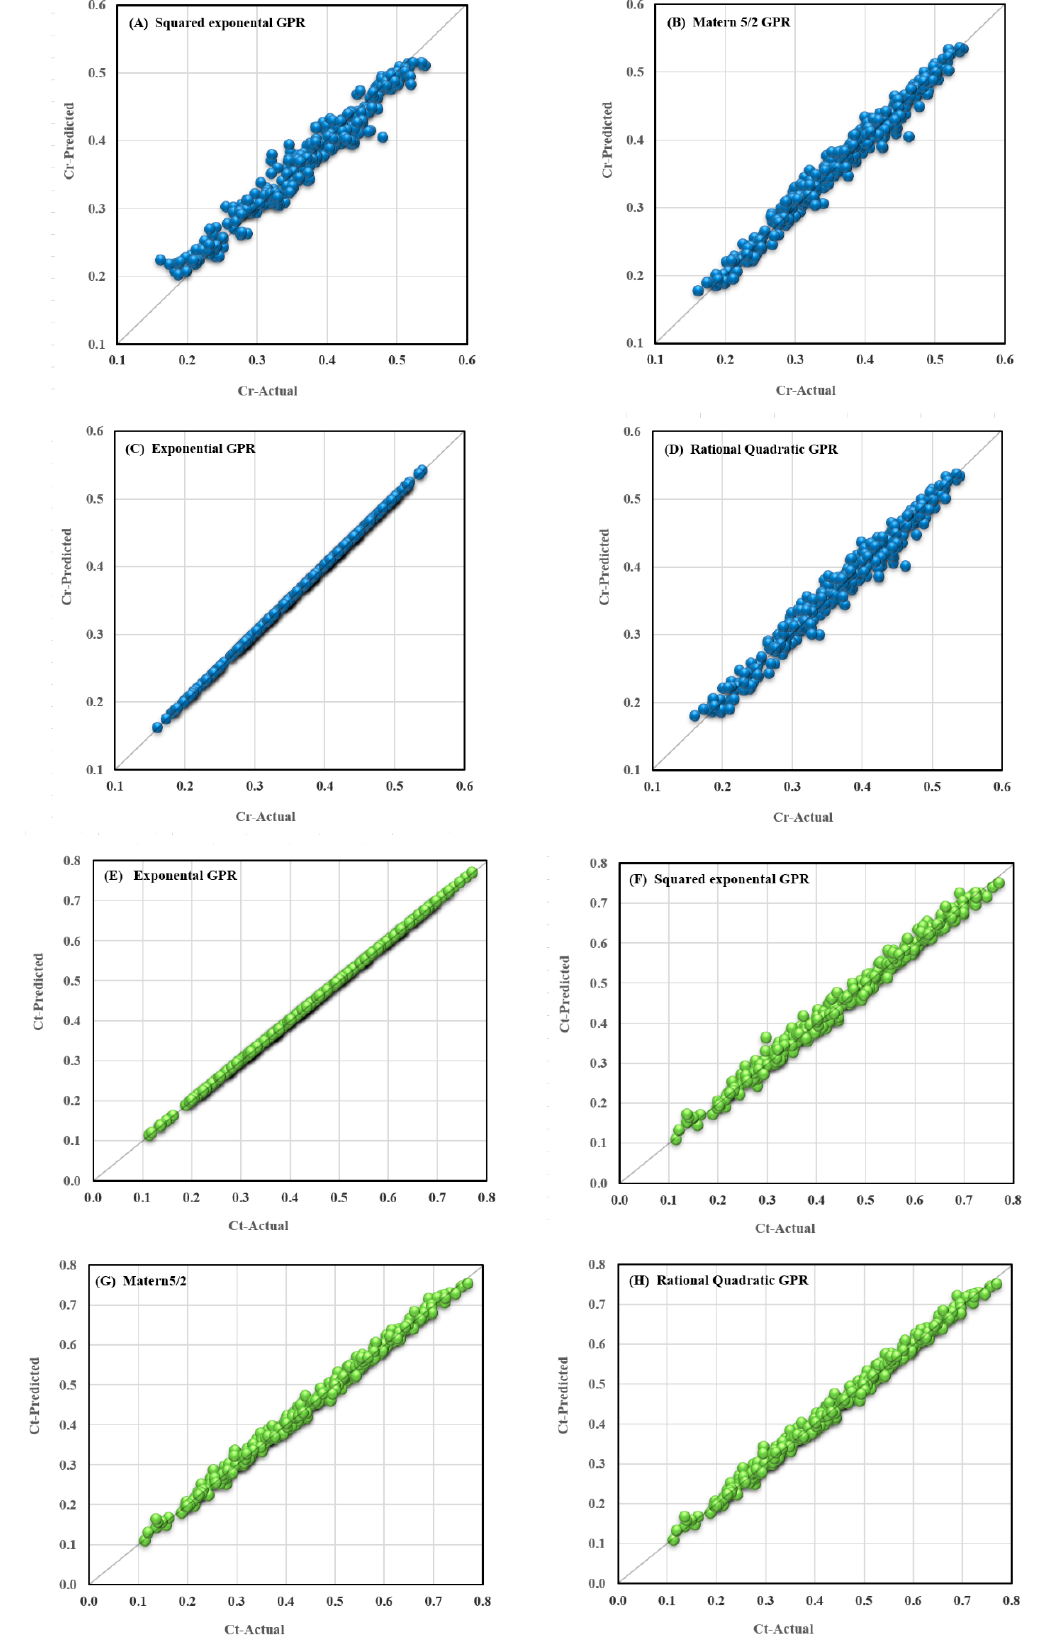
Figure 5. Measured versus predicted values for the top four models; ( A – D ) reflection prediction model and, ( E , F ) transmission prediction model.